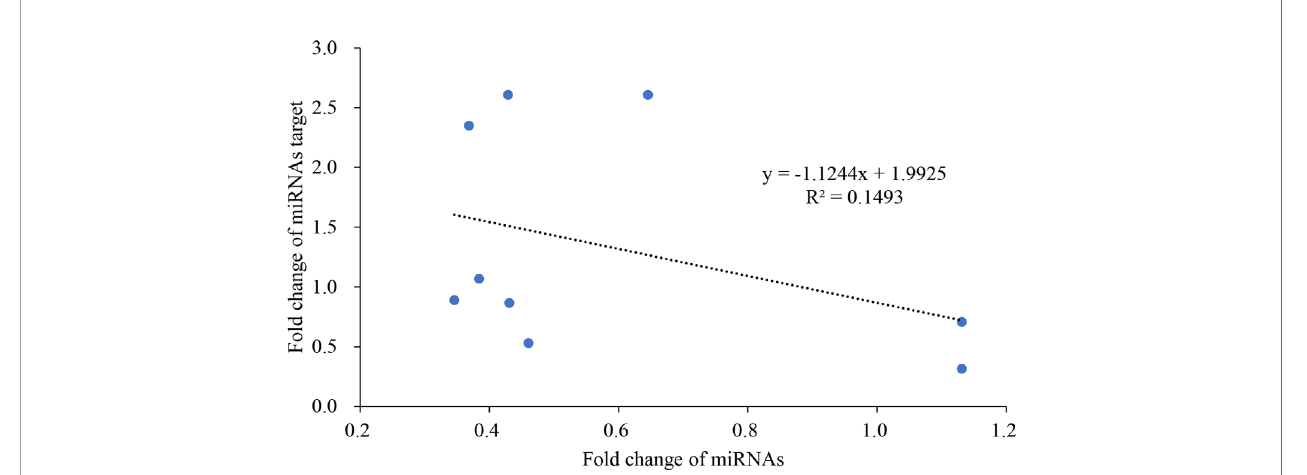
FIGURE 4 | The reverse linear relationship of fold change between miRNAs and their